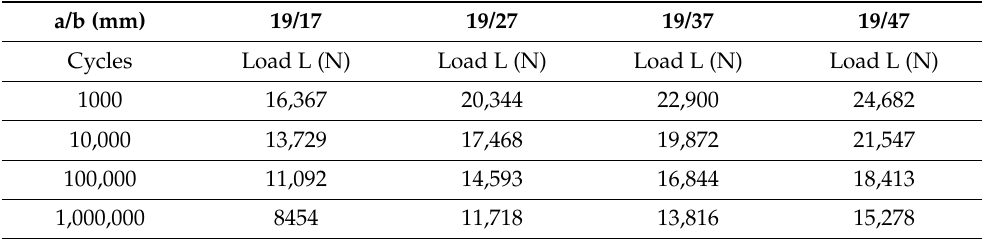
Figure 16. ( a ) Limit load to fatigue by the clamp ( a = 19 mm) determined by the proposed analytical expression as a function of the rear lever ( b ) of the clamp and as a function of the number of life cycles; ( b ) relationship between the increase in the value of the rear lever ( b ) with respect to the shortest rear lever ( b = 17). Table 2. Maximum load ( L ) to fatigue failure according to the size of the rear clamp lever ( b ) and the number of cycles, for a fixed size of the front clamp lever (a).